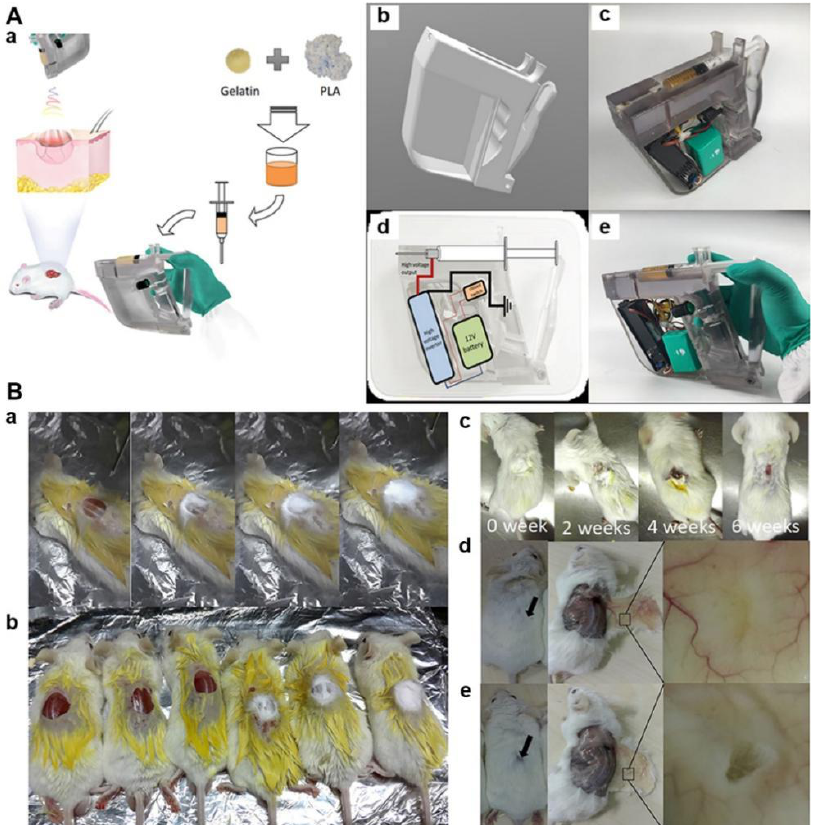
Figure 7 . Design and development of in situ gelatin/PLA nanofiber wound dressings by using a 3D printed handheld electrospinning device. ( A ) Design and fabrication of 3D printed and handheld electrospinning device for gelatin/PLA blend electrospinning. ( a ) Schematic illustration of the application of in situ gelatin/PLA nanofiber dressing for wound covering and healing; ( b ) Computer-aided design of the electrospinning hand-holder; ( c ) Photograph of the 3D printed handheld electrospinning device; ( d ) Circuit design of the electrospinning setup; ( e ) Photograph of the finally generated handheld electrospinning setup. ( B ) In situ repair of the acute injury wounds using mouse models. ( a ) A series of photographs using in situ electrospun gelatin/PLA nanofibers to cover the wound; ( b ) Photographs of mouse wounds after covering or not; ( c ) A series of photographs of mouse wound after in situ treatment using electrospun gelatin/PLA nanofiber mat; ( d ) Photographs of regenerated skins after 8 weeks of treatment using electrospun gelatin/PLA nanofiber mat; ( e ) Photographs of regenerated skins after 8 weeks of treatment using commercial gauze. Reprinted with permission from ref [133], Frontiers, 2021.